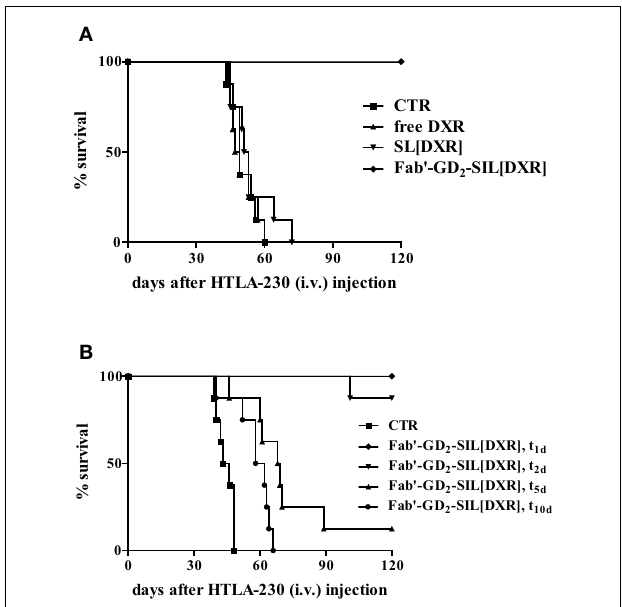
FIGURE 4 | Survival of neuroblastoma-bearing mice after treatment with doxorubicin (DXR)-containing, GD 2 -targeted nanocarriers . (A) Nude mice received injections in the tail vein with 4 × 10 6 HTLA-230 cells and 1 and 3days post-inoculation mice received 5mg/kg of DXR.Treatment groups ( n = 8/group) consisted of DXR administered either free (free DXR) or encapsulated in untargeted [SL(DXR)] and targeted [Fab (cid:48) -GD 2 -SIL(DXR)] nanocarriers. (B) Nude mice (8/group), inoculated i.v. with 4 × 10 6 HTLA-230 cells, were treated on days 1, 2, 5, or 10 with 8mg DXR/kg/week × 2 as Fab (cid:48) -GD 2 -targeted nanocarriers [Fab (cid:48) -GD2-SIL(DXR), t 1 , t 2 , t 5 , t 10 , respectively). Control mice (CTR) received HEPES-buffered saline. Partially reproduced from Pastorino et al.